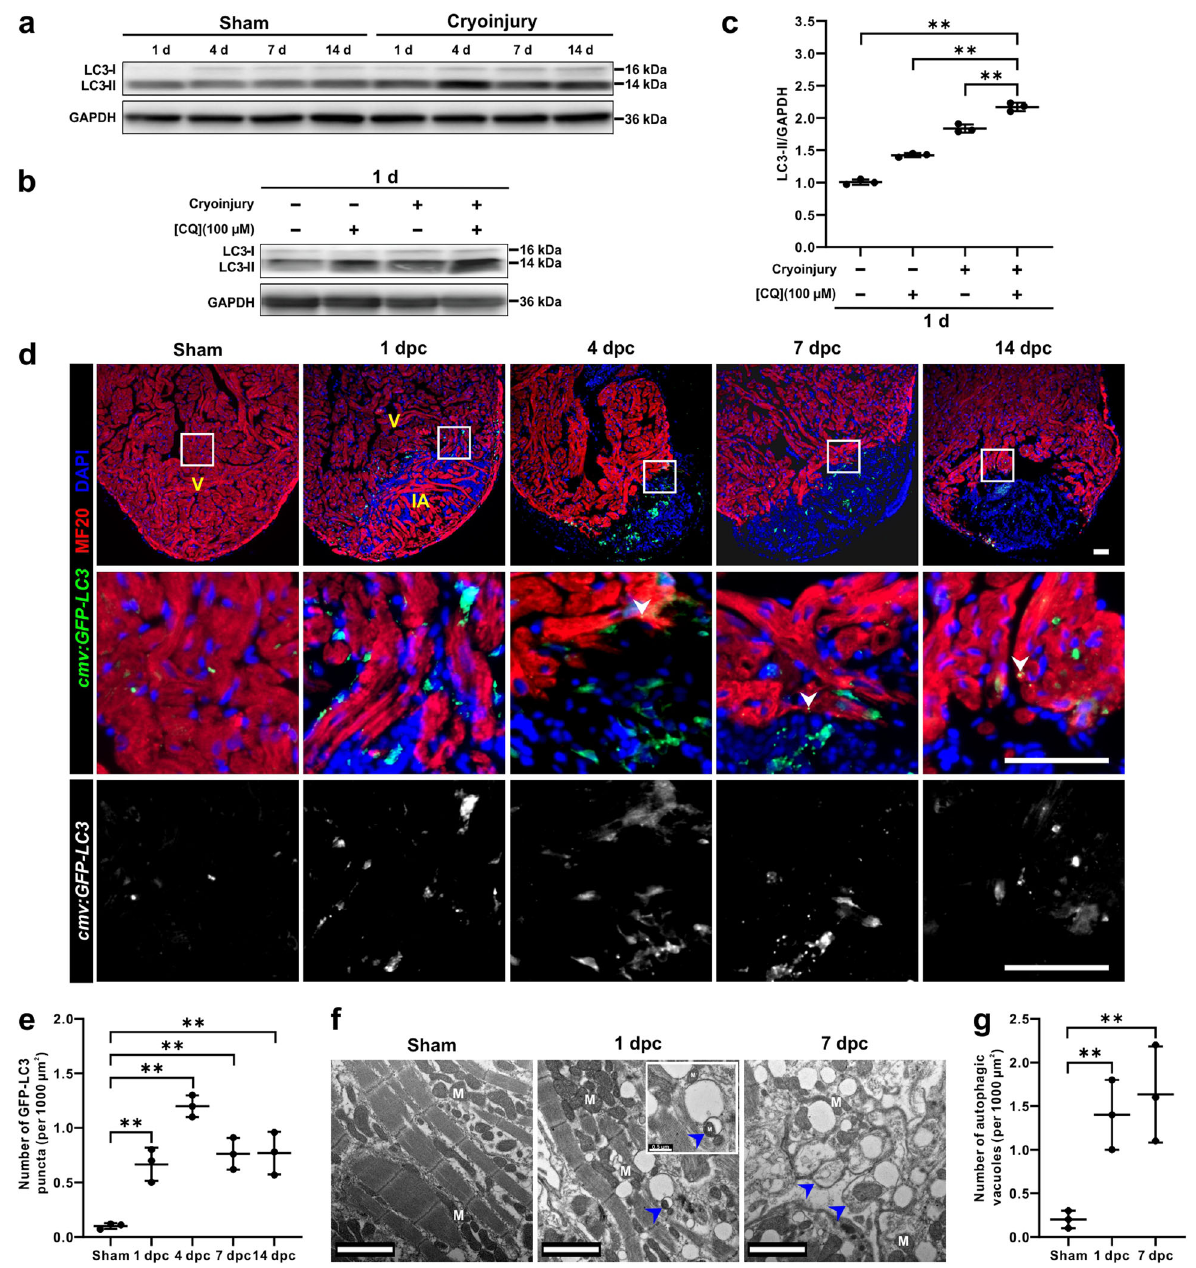
Fig. 1 Autophagy is upregulated during zebra fi sh heart regeneration. a Western blot analysis was performed to detect the expression of LC3-I and LC3-II in intact (sham control) and regenerating hearts from 1 to 14 days. The protein from three hearts was loaded into each lane, and GAPDH was used as the loading control. b , c Autophagic fl ux assay with a western blot of LC3 was conducted ( b ). The expression of LC3-II was quanti fi ed. The data are presented as mean ± SD, n = 3 repeats, ** P < 0.01 vs cryoinjured hearts with CQ treatment ( c ). d , e The sham (control) or cryoinjured hearts of Tg ( cmv : GFP-LC3 ) fi sh were isolated, embedded in paraf fi n, sectioned, and dual-immunostained with an anti- GFP antibody to detect LC3 (in green) and an anti-MF20 antibody to detect the cardiomyocytes (in red), after which they were co-stained with DAPI to label the nuclei (in blue). IA: injured area; V: ventricle. The arrowheads show the GFP-LC3 puncta in cardiomyocytes. Scale bars: 50 µm ( d ). The number of GFP-LC3 puncta in sham and in the injured area at 1 dpc, 4 dpc, 7 dpc, and 14 dpc was quanti fi ed. The data are presented as mean ± SD, n = 3 hearts, ** P < 0.01 vs sham ( e ). f , g Electron micrographs of an intact (sham) heart, and a regenerating heart in the IA at 1 dpc and 7 dpc. In the injured area, there was an accumulation of autophagic vacuoles (see blue arrowheads). M: mitochondria. Scale bars: 2 µm ( f ). The number of autophagic vacuoles in sham and the injured area at 1 dpc and 7 dpc was quanti fi ed. The data are presented as mean ± SD, n = 3 hearts, ** P < 0.01 vs sham ( g